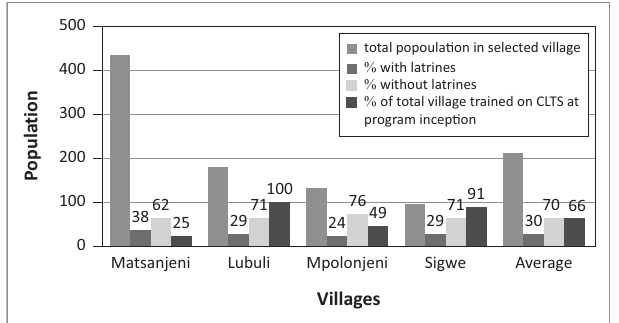
FIGURE 4: Status of selected villages at project inception.